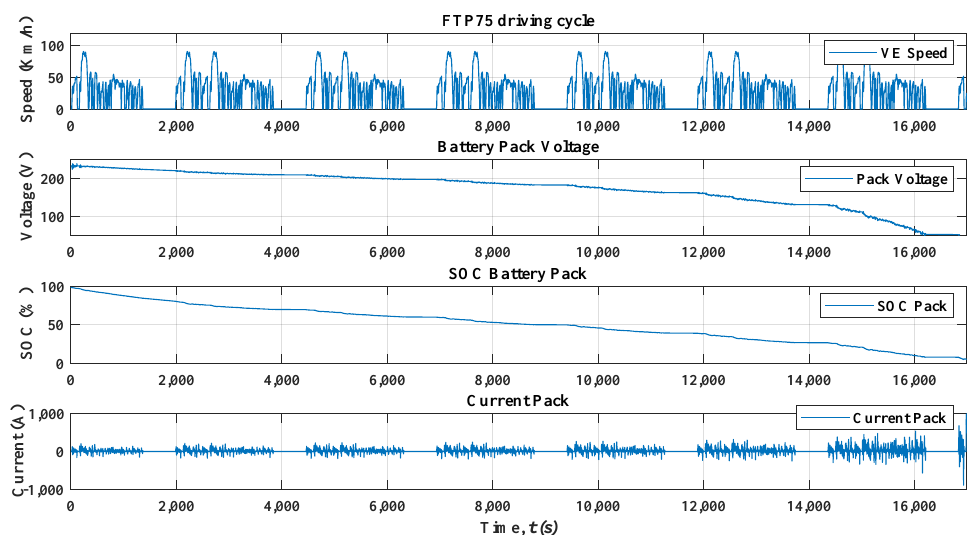
Figure 11. Simulation results of the EV model. The driving cycle is repeated until the battery pack is fully discharged. The equalization of stacks and cells is done by the passive method.